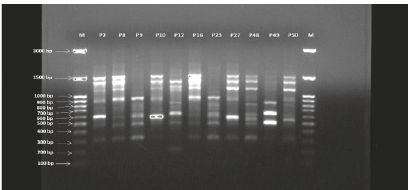
Figure 4: ERIC pattern of A. baumannii from patients’